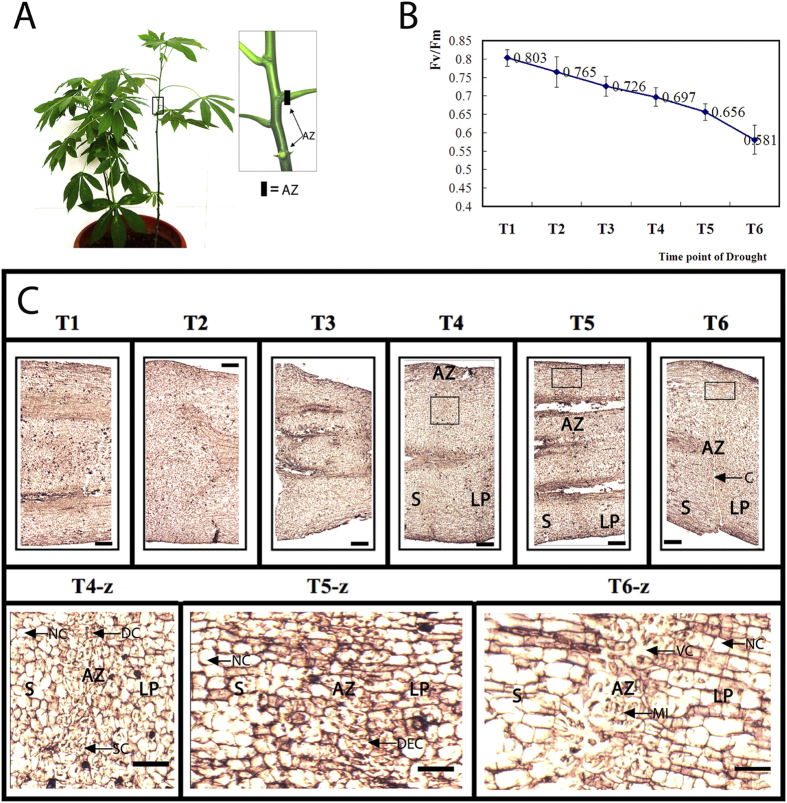
The pulvinus AZ cell separation appeared at the later stages under water-deficit stress in cassava.(A) Cassava plants and the pulvinus AZ. Schematic presentation of the cassava pulvinus AZ showed in the rectangles on the right side. AZ tissues selected as samples; (B) Fv/Fm was measured over 17 days, from Day 0, which was still well-watered. Six time points were selected during water-deficit stress. Three leaves in the middle of the cassava plants were sampled, with 3 cassava plants in a culture pot, and 5 pots for 1 treatment. The whole experiment was repeated 3 times. Each value represents the mean ± S.E. of 45 plants; (C) The process of the pulvinus abscission zone cell separation observed by microscope. The AZs were selected from leaves used for detection of Fv/Fm values and prepared in paraffin before section preparation and microscopic detection. T4-z, T5-z and T6-z represent, respectively, the rectangles shown in T4, T5 and T6. S: Stem, AZ: Abscission zone, LP: leaf petiole. SC: smaller cell, DC: dense cell, DEC: deformation cell, VC: vacuolar cell, MI: membrane invagination cell, C: crack, NC: normal cell. Bars in photographs T1 to T6 represent 1000 μm, Bars in photographs T4-z to T6-z represent 100 μm.